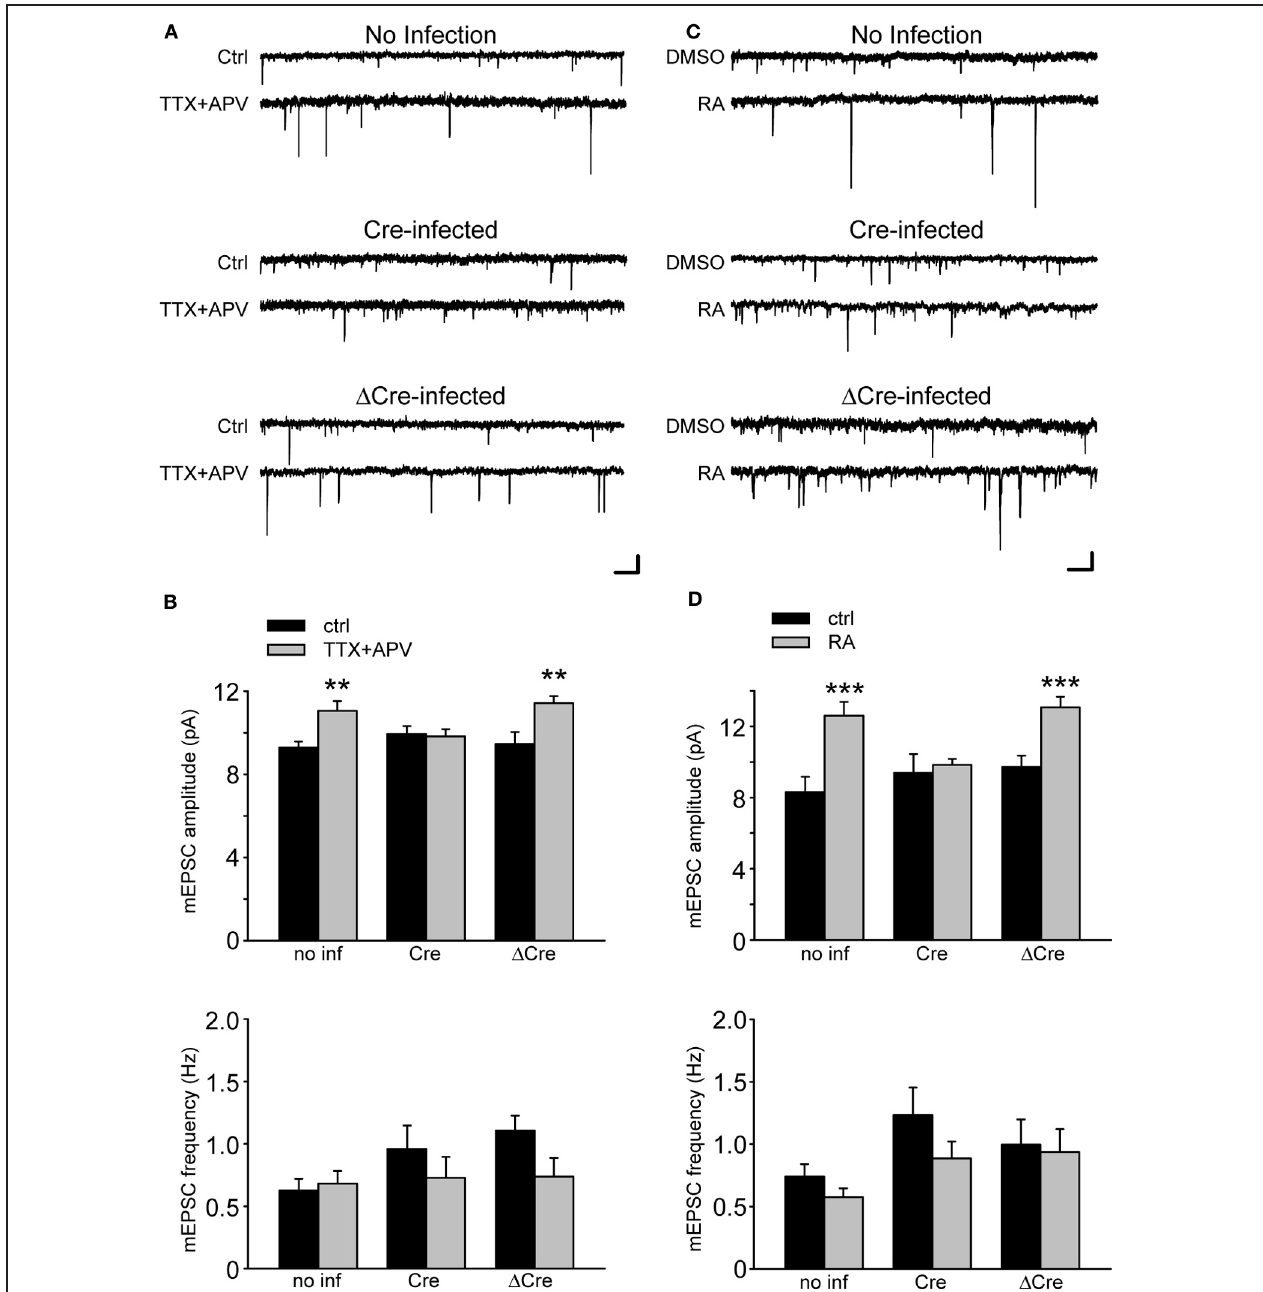
FIGURE 2 | Retinoic Acid Receptor α is required in synaptic scaling induced by activity blockade and by retinoic acid (RA). (A) Representative traces of mEPSCs from RAR α fl/fl neurons infected with a lentiviral vector expressing Cre-recombinase or the inactive (cid:2) Cre. Neurons have been treated with TTX and APV for 24h. Scale bars: 10pA, 0.5s. (B) Quantification of average mEPSC amplitude (no inf/ctrl: 9 . 29 ± 0 . 29pA; no inf/TTX + APV: 11 . 05 ± 0 . 46pA; Cre/ctrl: 9 . 94 ± 0 . 39pA; Cre/TTX + APV: 9 . 83 ± 0 . 34pA; (cid:2) Cre/ctrl: 9 . 46 ± 0 . 57pA; (cid:2) Cre/TTX + APV: 11 . 43 ± 0 . 33pA; n = 12–19 from three independent experiments; ∗∗ p < 0 . 005) and frequency (no inf/ctrl: 0 . 63 ± 0 . 09Hz; no inf/TTX + APV: 0 . 68 ± 0 . 10Hz; Cre/ctrl: 0 . 96 ± 0 . 19Hz; Cre/TTX + APV: 0 . 73 ± 0 . 17Hz; (cid:2) Cre/ctrl: 1 . 11 ± 0 . 12Hz; (cid:2) Cre/TTX + APV: